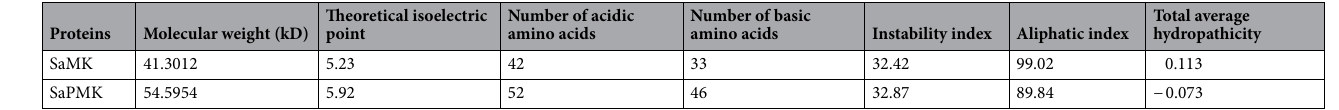
Table 2. Physicochemical properties of deduced proteins in Santalum album .